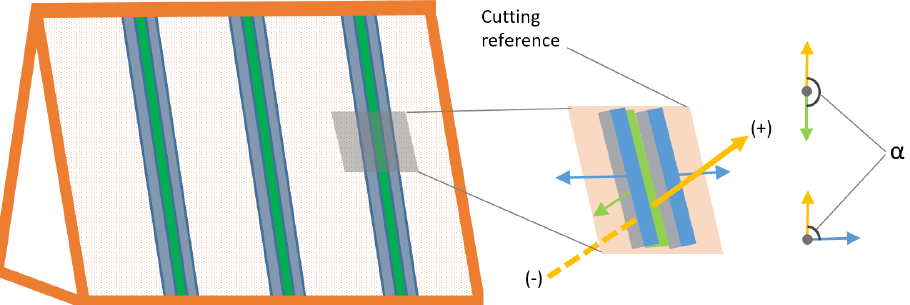
Figure 5. Side beam faces cut by reference surface (light-blue), interior side face regions (gray) and equivalent orthogonal face